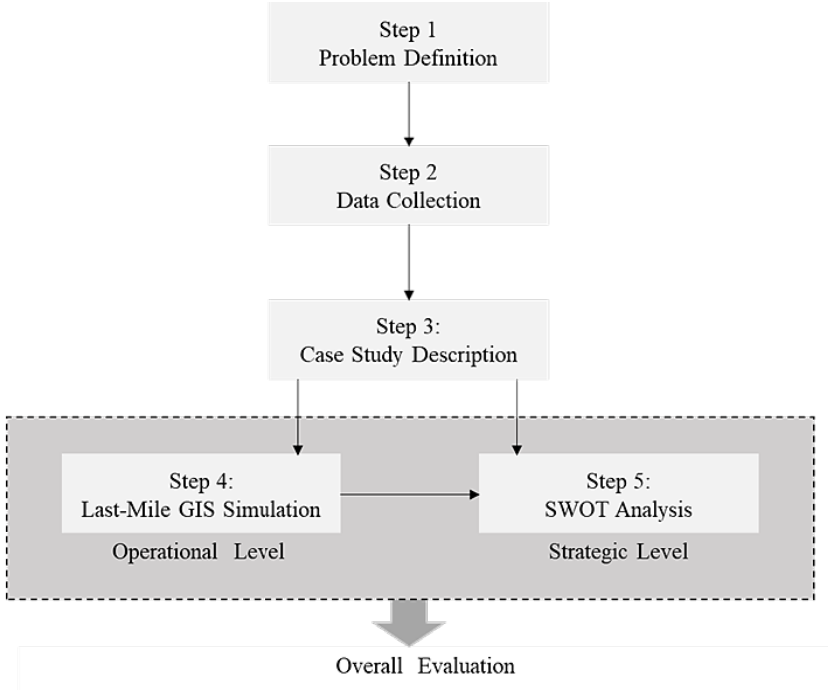
Fig. 2. Proposed 2-level and 5-step methodological